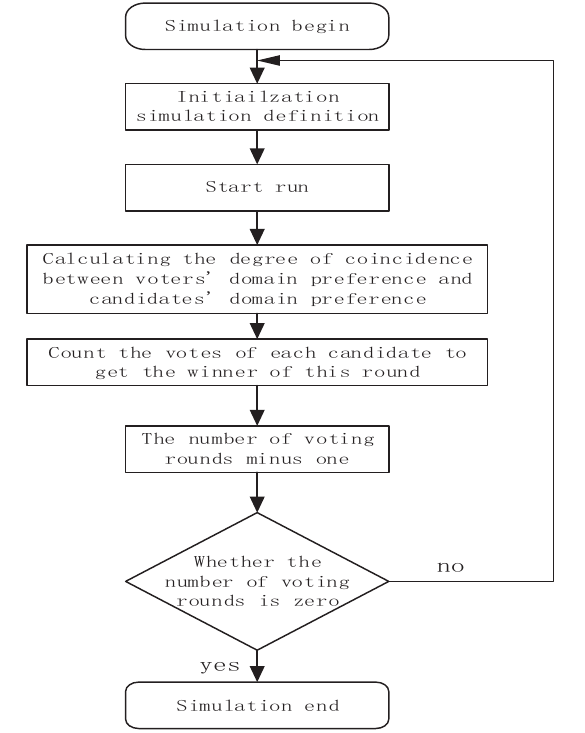
Figure 5. Flow chart of the simulation